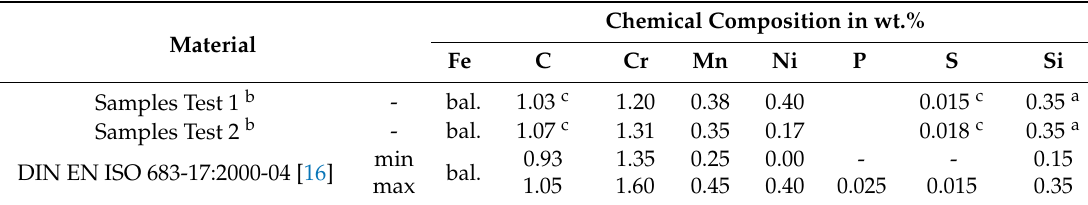
Table 1. Chemical composition of the used alloy SAE52100 in wt.% in comparison with the required chemical composition of the DIN EN ISO